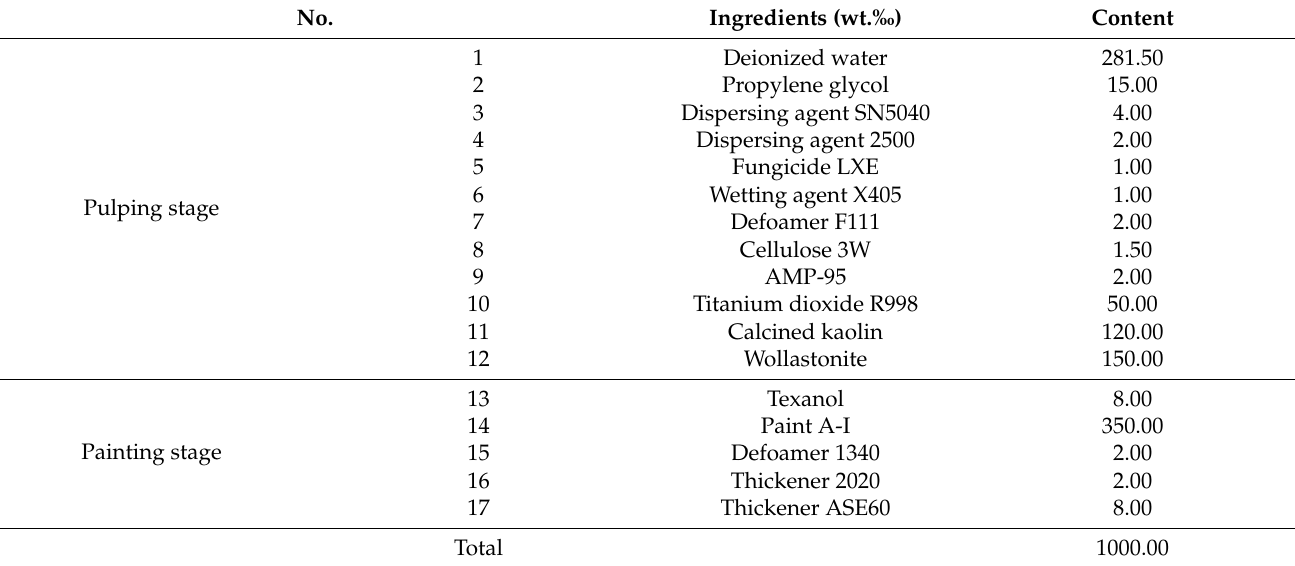
Table 2. Compositions of the paints for Design